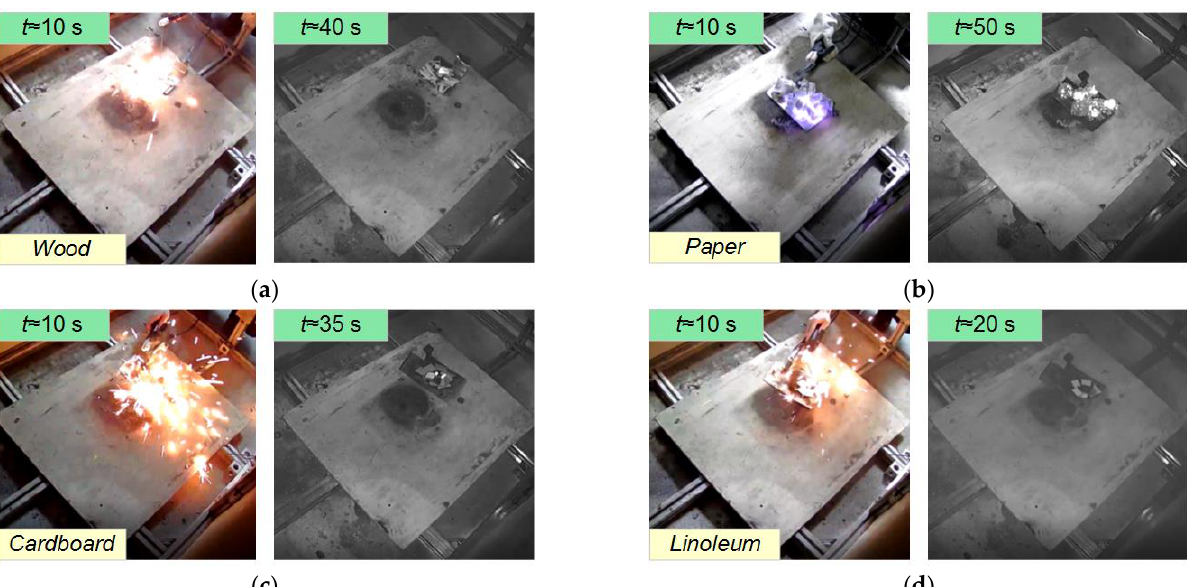
Figure 5. Images of model fire when simulating improper use and emergency operation of electrical equipment and networks (electric discharge generation with a welder) at the stages (from left to right) of ignition (short circuit), flame combustion, smoldering and extensive smoke generation: ( a ) wood; ( b ) paper; ( c ) cardboard; ( d ) linoleum.